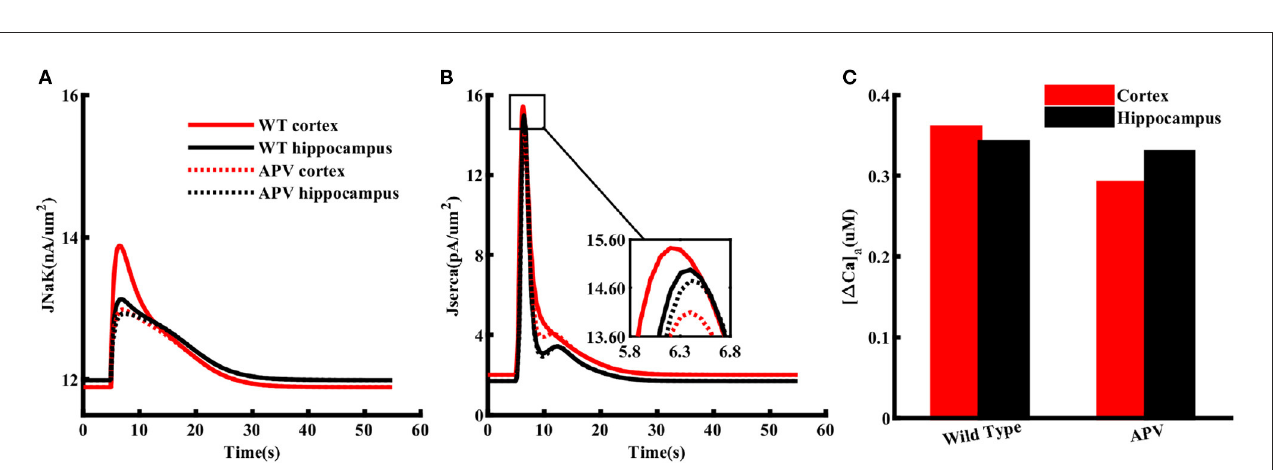
FIGURE7 NMDA receptors cause higher ATP consumption in cortical astrocytes than those in the hippocampus. Flux through Na + /K + pumps (A) and SERCA (B) in normal condition (solid lines) and in the presence of APV (dotted lines) in cortical (red) and hippocampal (black) astrocytes exposed to 1 mM glutamate for 100 ms. (C) Peak changes in Ca a during the simulations shown in (A)